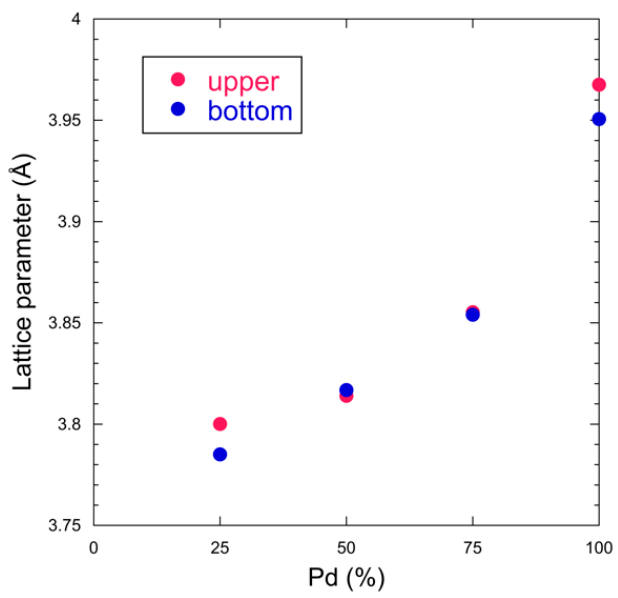
Figure 4. Lattice parameter versus Pd ratio of Pd-Fe alloy nanoparticles and pure Pd (100%)